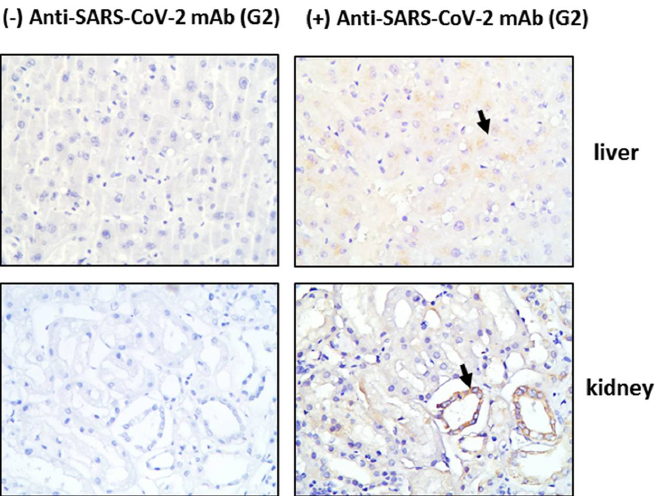
Figure 2. SARS-CoV-2 detection in tissues from critical COVID-19 patients. Post-mortem tis- sue samples were obtained and directly processed for detection of SARS-CoV-2 by immunohistochemistry. Representative images of SARS-CoV-2 (G2 mab) staining in liver and kidney tissue sections and their respective negative controls. Magnification at X400.